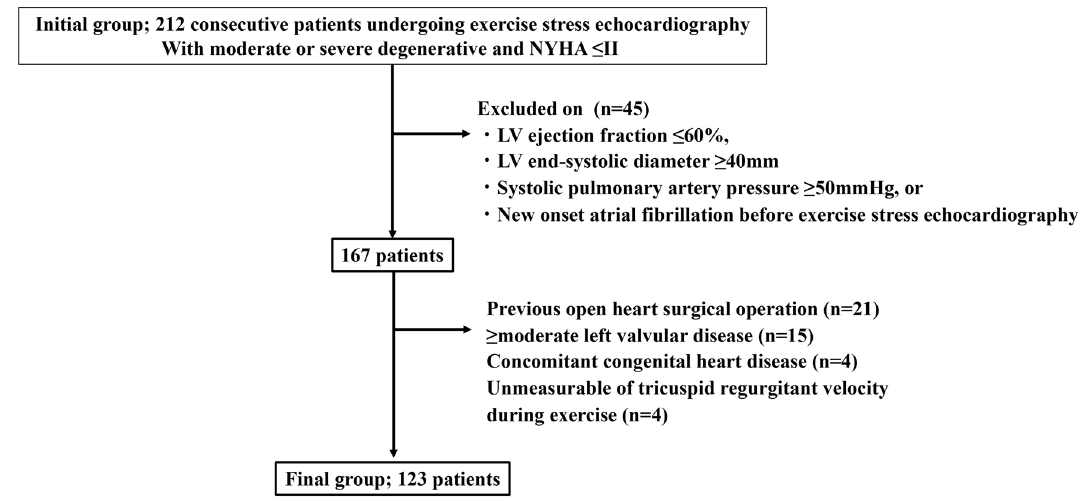
Figure 4. Flowchart of the recruitment of patients. NYHA New York heart association, LV left